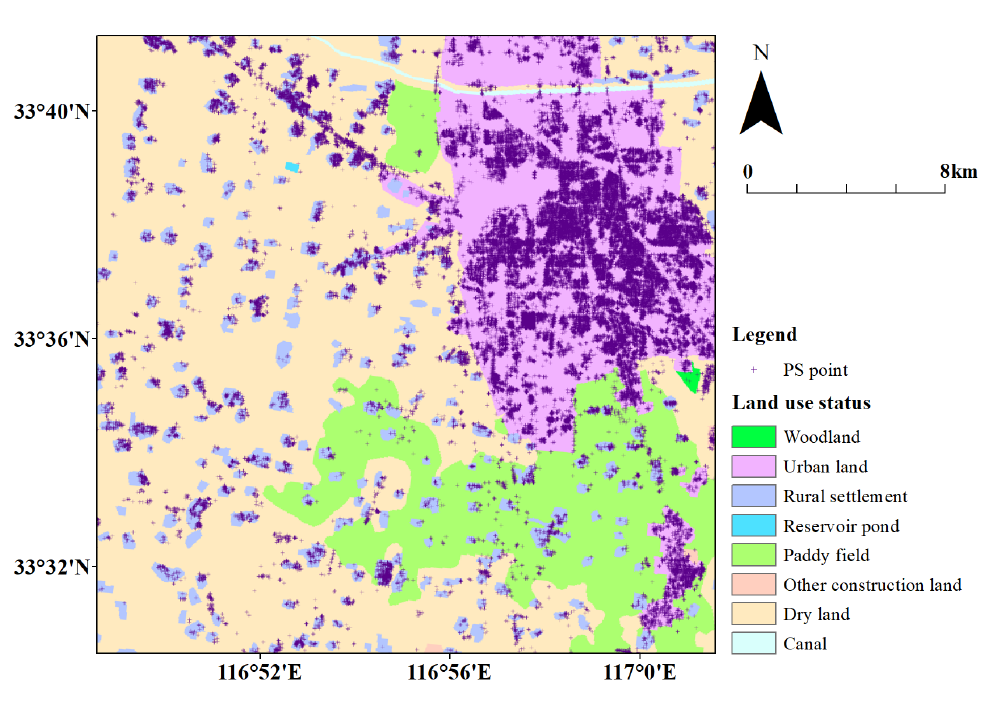
Figure 10. Classification of land use and distribution of PS points in Suzhou